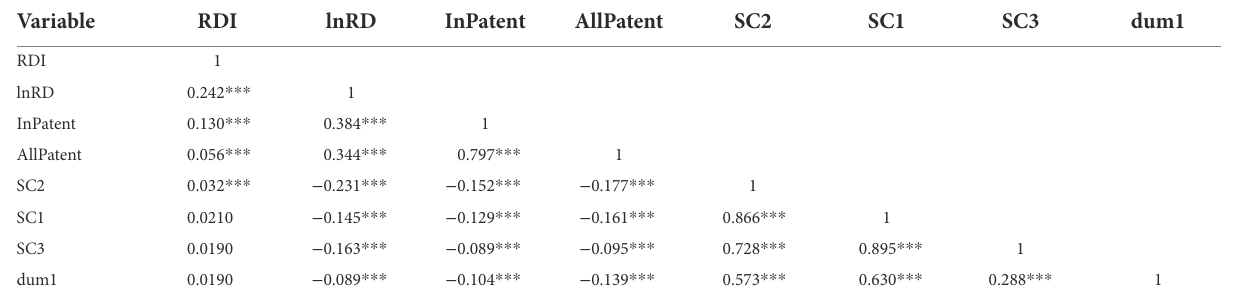
TABLE 3 Correlation